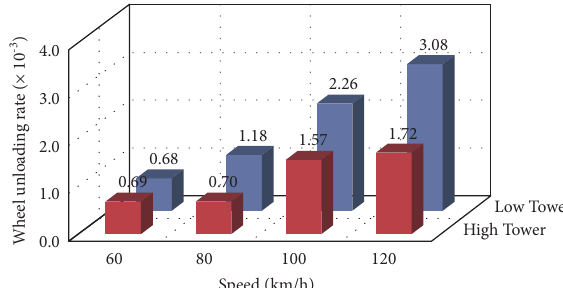
Figure 10: Comparison of wheel unloading